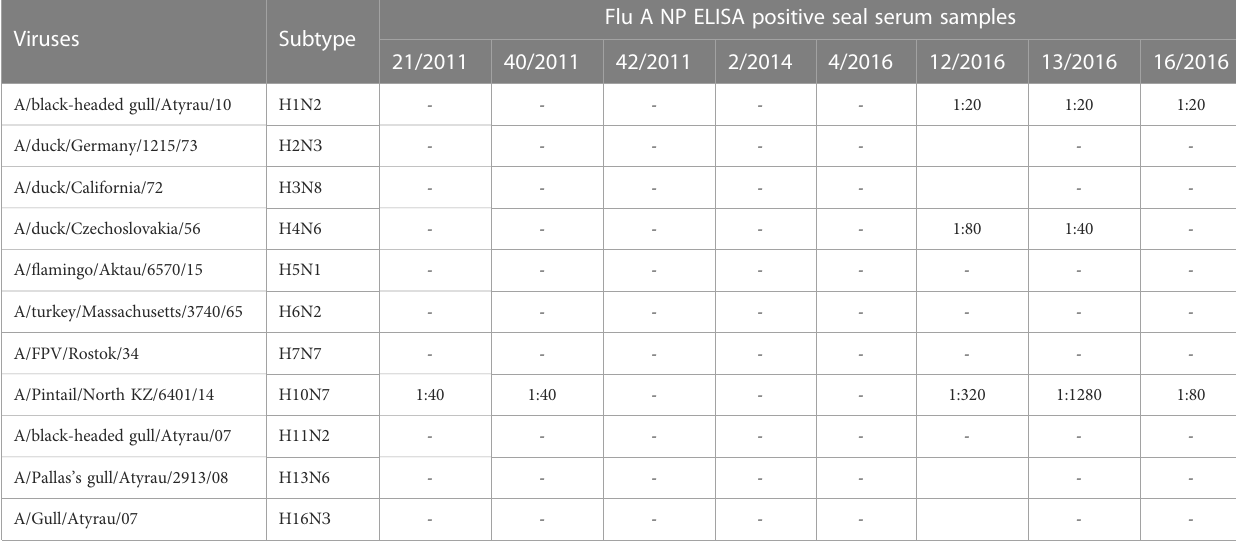
TABLE 3 Hemagglutination inhibition (HI) titers of In fl uenza A (NP) for 8 ELISA positive Caspian seal serum samples.